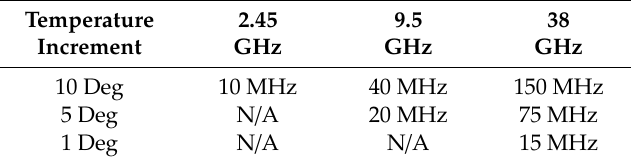
Table 4. Frequency shift over temperature sweep (measured results in MHz).